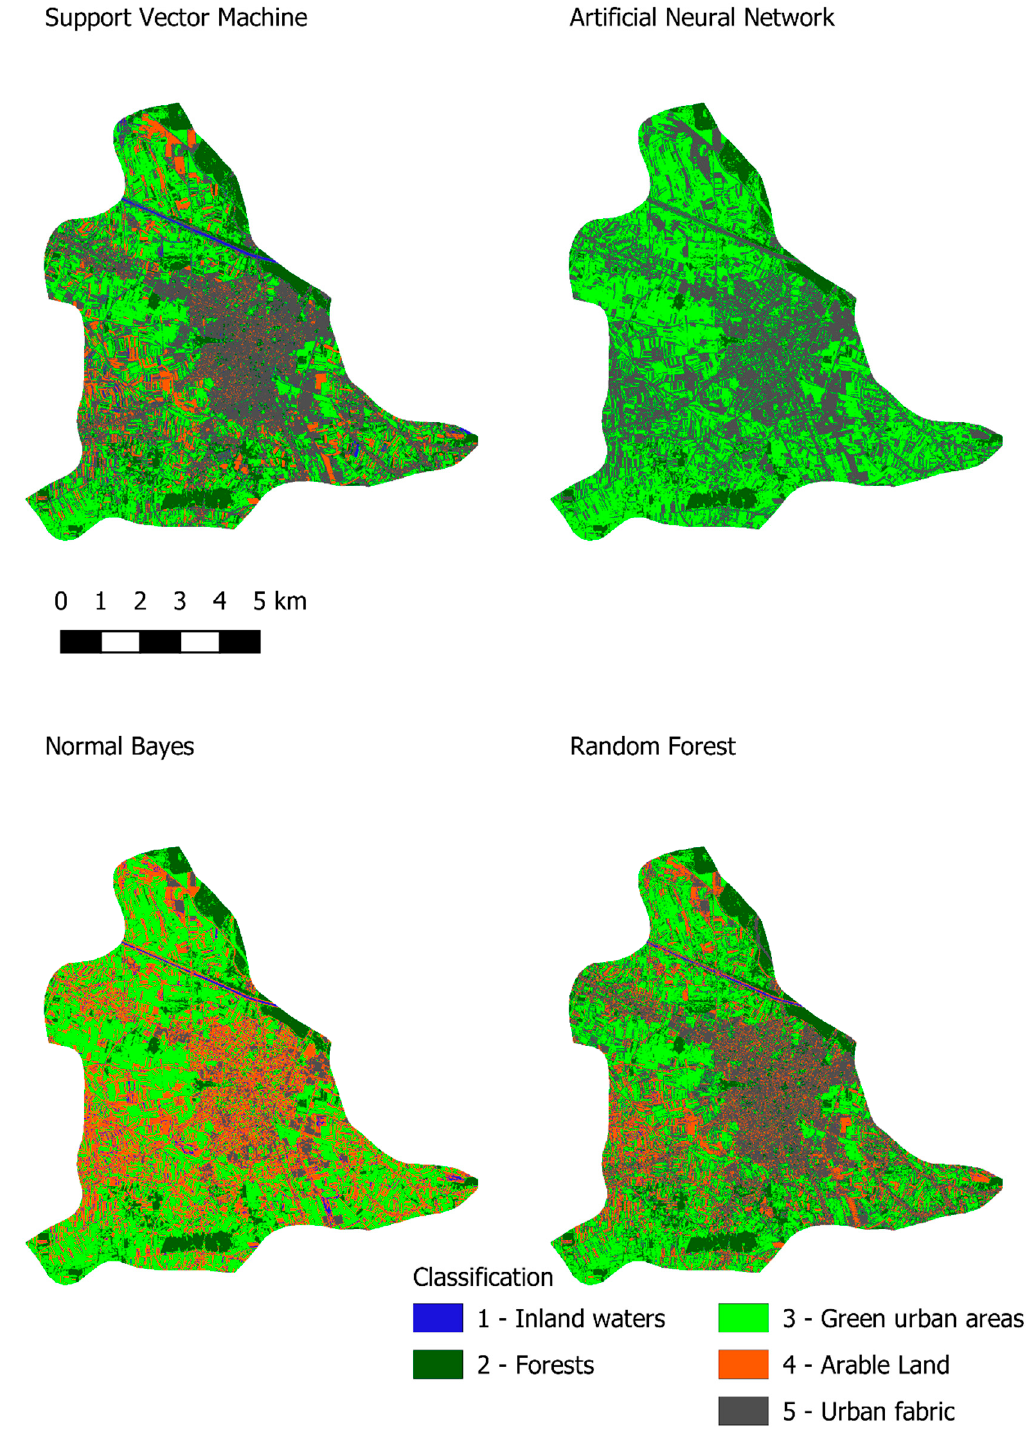
Figure 2. The classification results for the Varaždin study area.